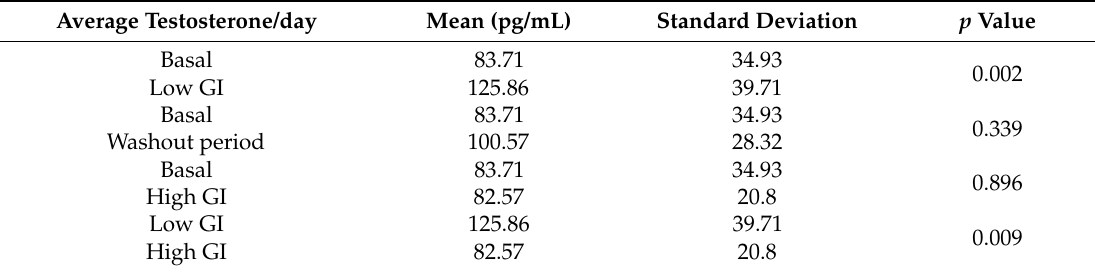
Table 1. Testosterone values at basal, low glycaemic index (GI), washout and high-GI diet. Average Testosterone/day Mean (pg/mL) Standard Deviation p